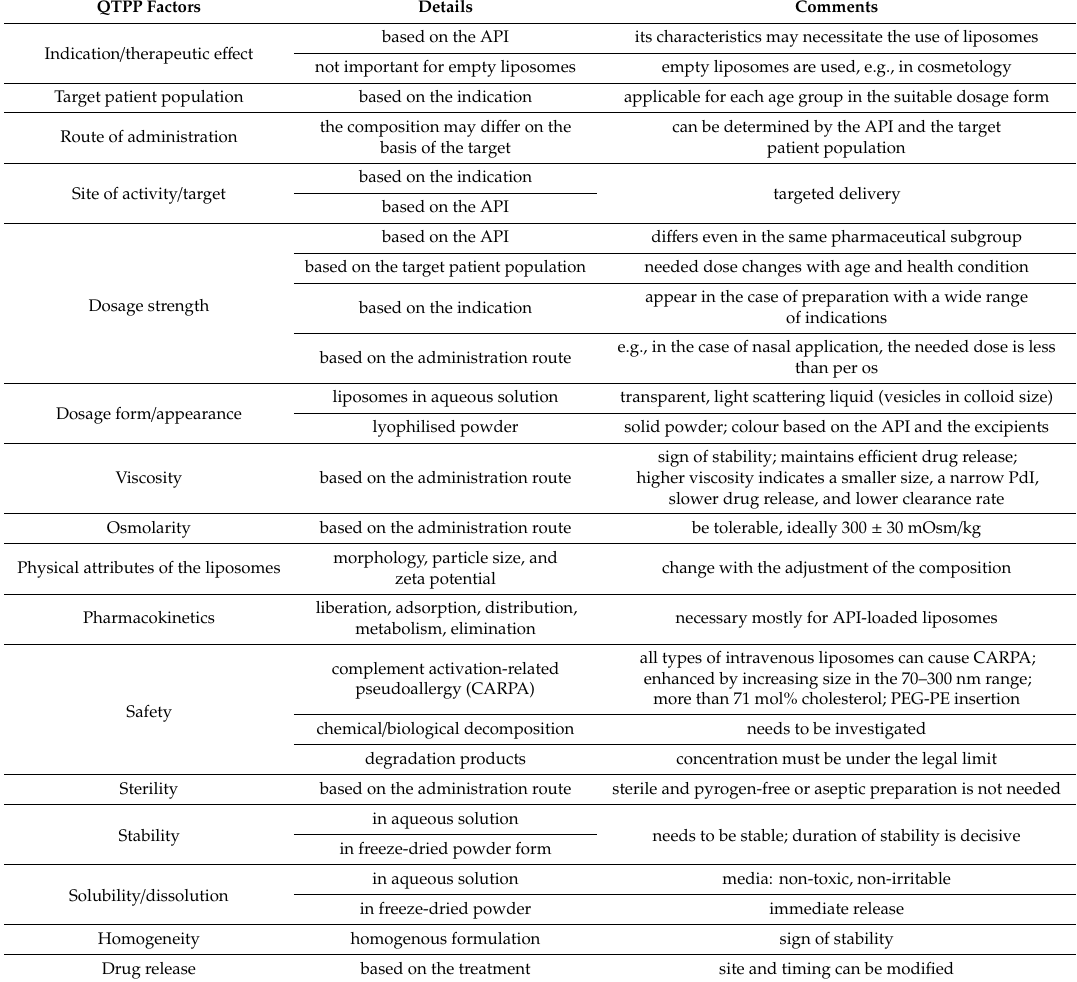
Table 2. Collection of the possible factors of the quality target product profile (QTPP) for a liposome-based